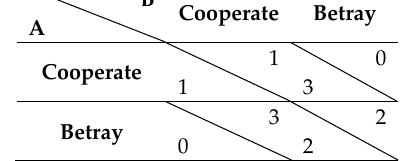
B Cooperate Betray A 1 0 Cooperate 1 3 3 2 Betray 0